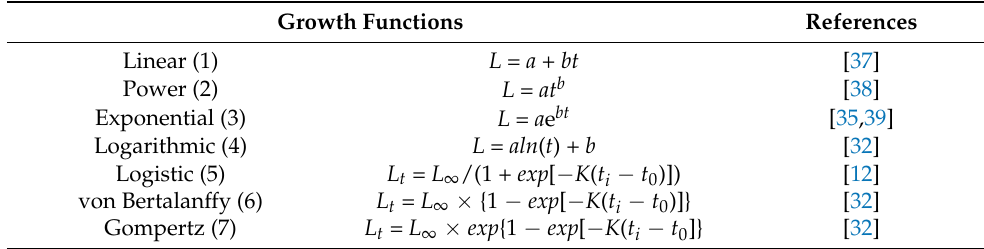
Table 1. Types of growth